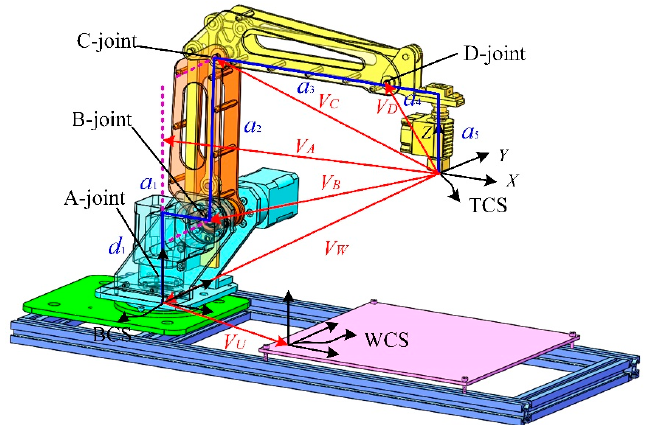
Figure 1. The structural parameters of one multijoint industrial robot.